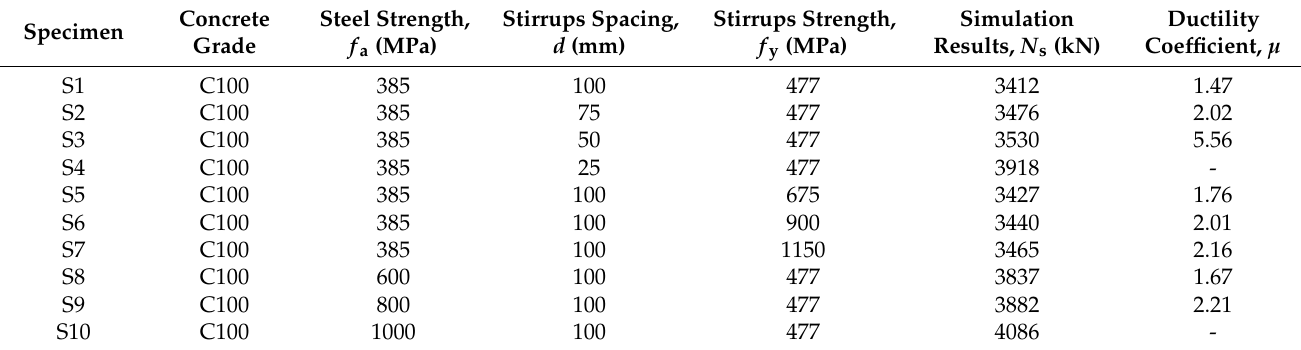
Table 6. The simulation results of the finite element expansion parameters.